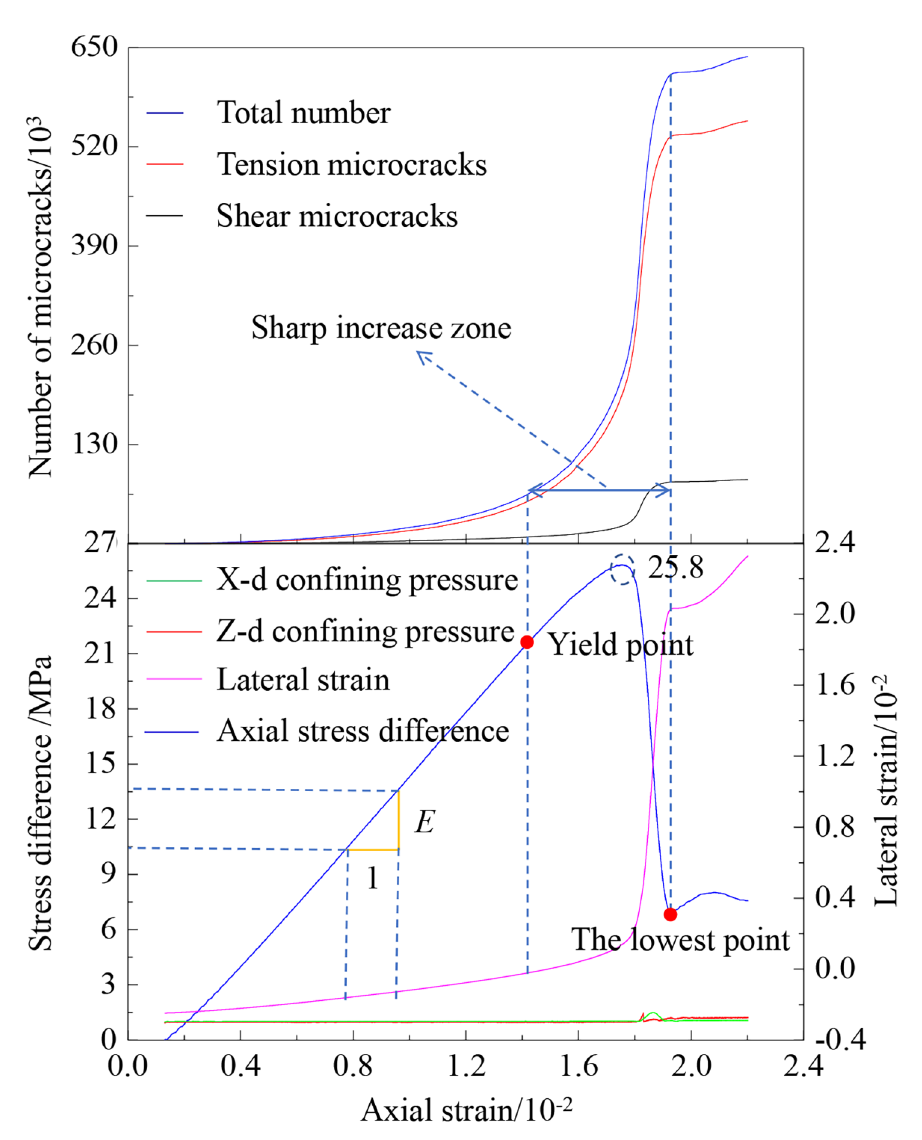
Fig. 10 Numerical results of stress and strain for jointed coal with REV size after triaxial com - pression with loading perpen- dicular to face cleats. X -d and Z -d refer to the X - and Z -directions,